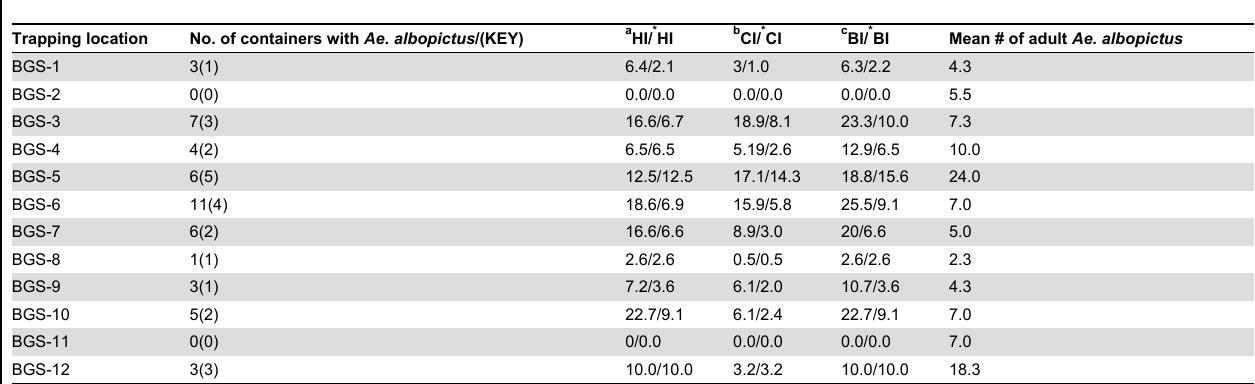
Table 5. Container and Breteau index profile for Ae. albopictus for each BGS trapping location using a 50 m radius buffer area during August